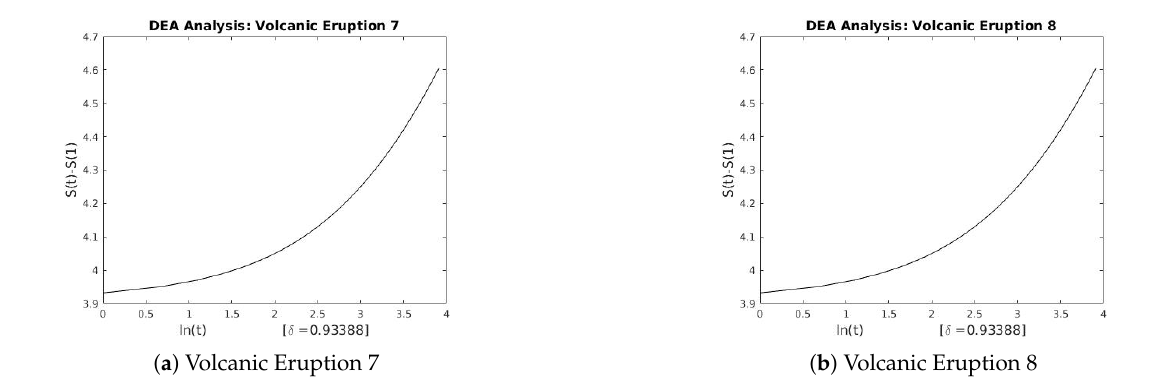
Figure A18. DEA for Volcanic Eruption 7 and